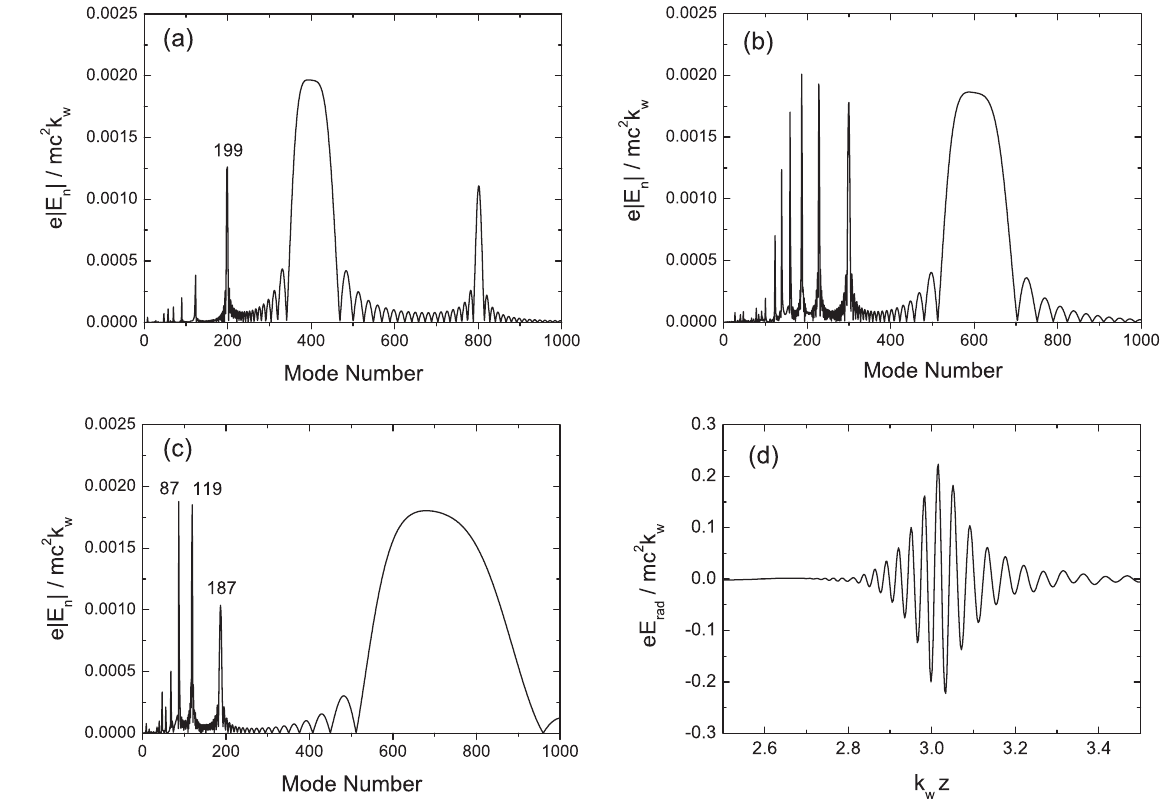
j =mc 2 k is the n w